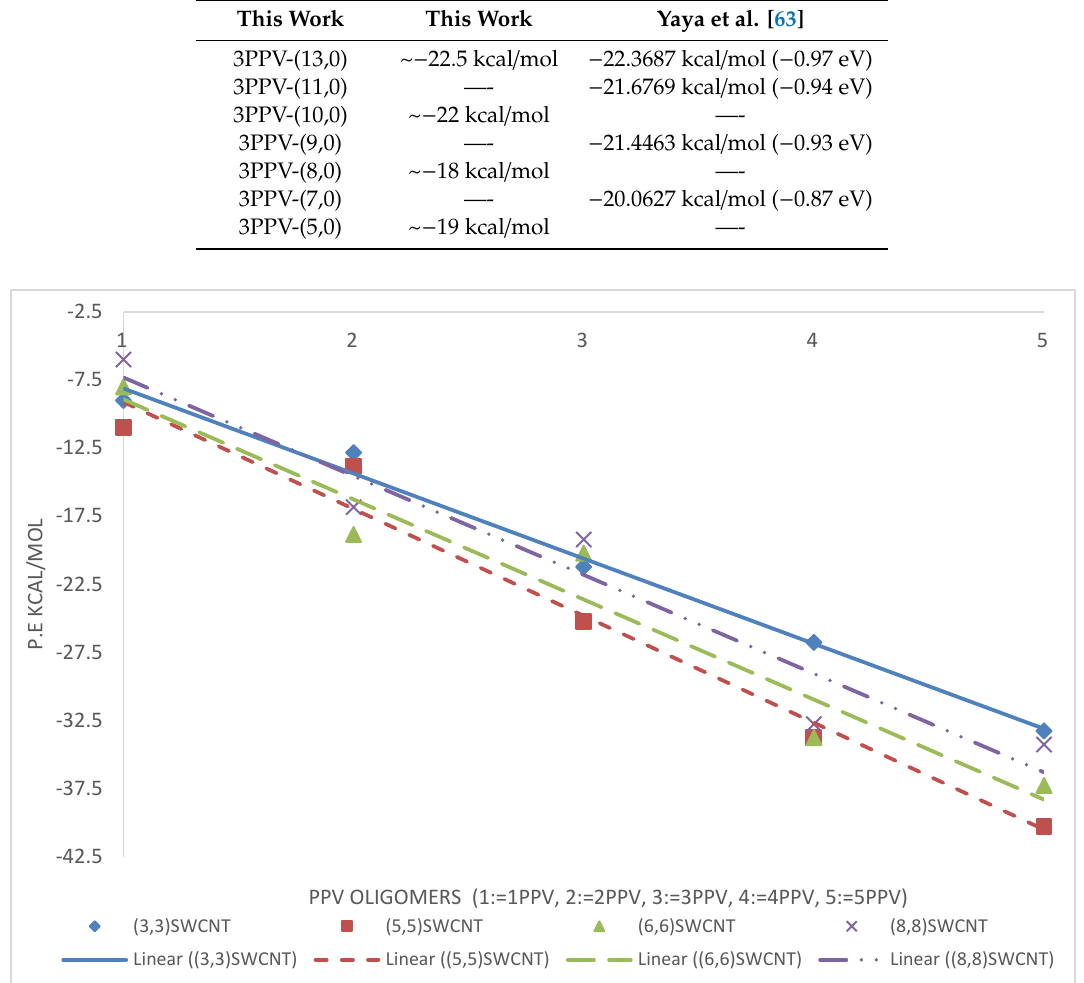
Table 5. Binding energies of 3PPV w.r.t semiconductor SWCNT.